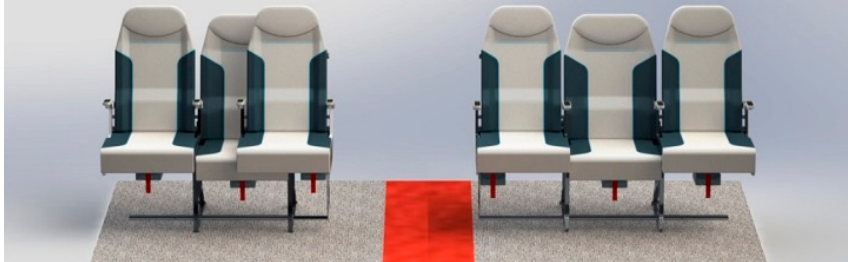
Figure 14. Side-Slip Seat provides a wider aisle for boarding: seat in initial condition ( left ) and unfolded operational condition ( right ) [54].